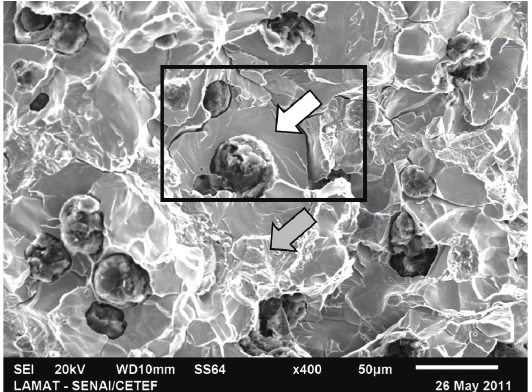
Figure 6. Fracture surface of broken Charpy test specimen.